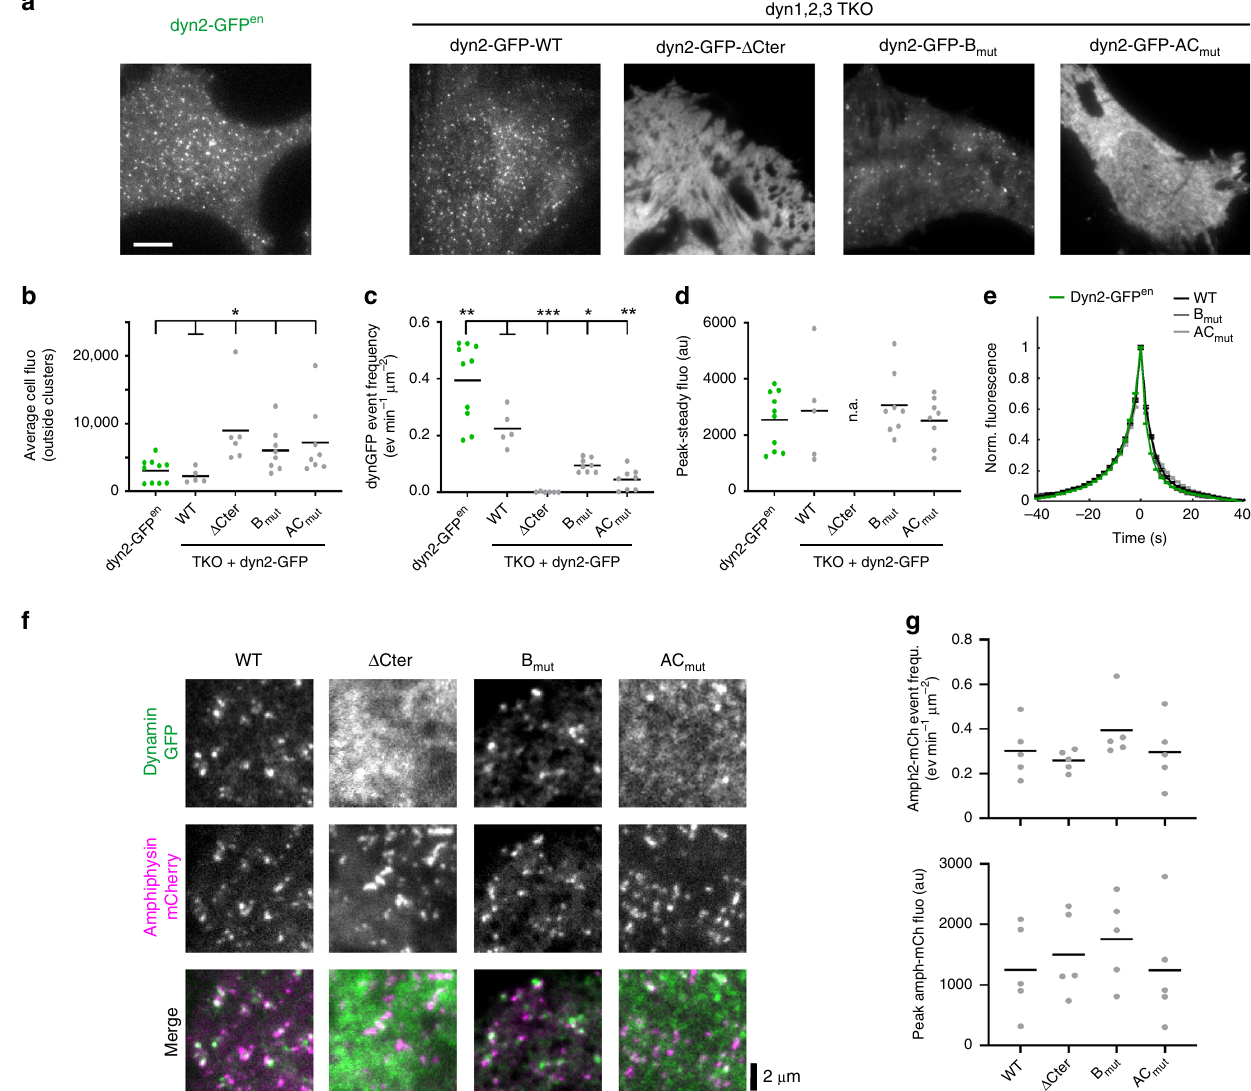
Fig. 2 Frequency and kinetics of dyn2 recruitment events in dynPRD mutants. a TIRF images of living SKMEL cells expressing dyn2-GFP in both endogenous loci (left) or dynamin TKO MEF cells transfected with the indicated dyn2-GFP mutants (right). Scale bar 10 µ m. b Average fl uorescence outside the dyn2- GFP clusters for the various dyn2-GFP mutants. The number of cells recorded is indicated at the top of the graph. c dyn2-GFP recruitment event frequencies for the same cells as in ( b ). d Average amplitudes of peak dyn2-GFP events for the same cells as in ( b ), except for cells transfected with dyn2- GFP- Δ Cter (n.a.). e Normalized average fl uorescence of all the events detected, aligned to their peak fl uorescence. The total number of events averaged was 36070 for dyn2-GFPen cells and 18678, 127, 5916 and 6116 for TKO cells transfected with dyn2-GFP-WT, dyn2-GFP- Δ Cter, dyn2-GFP-B mut and dyn2- GFP-AC mut , respectively. f TIRF images of portions of dynamin TKO cells co-transfected with amphiphysin-mCherry and the indicated dyn2-GFP mutants. Scale bar 2 µ m. g Frequencies (top) and peak amplitudes (bottom) of amph-mCherry recruitment events recorded in dynamin TKO cells co-transfected with the indicated dyn2-GFP mutants. N = 5 – 7 cells for each condition, no signi fi cant difference with WT in any